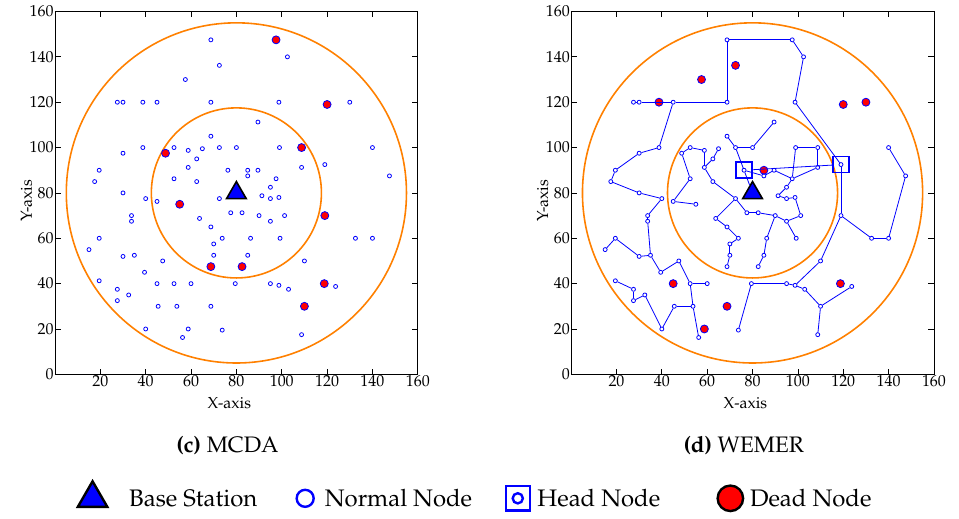
Figure 19. Network topology after Ten percent node die (a) at 645 th round for PEGASIS (b) at 751 st round for CCS (c) at 601 st round for MCDA (d) at 938 th round for WEMER. round for CCS ( c ) at 601st round for MCDA ( d ) at 938th round for WEMER.